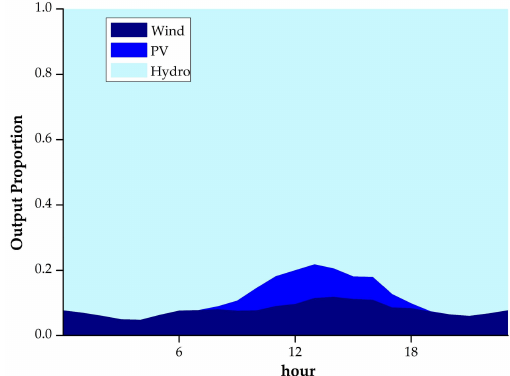
Figure 8. Dispatch scheme of